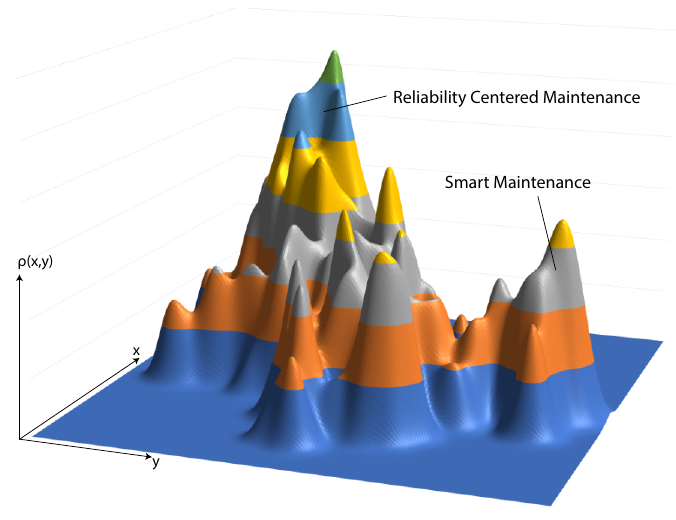
Figure 15. Article Density Surface.